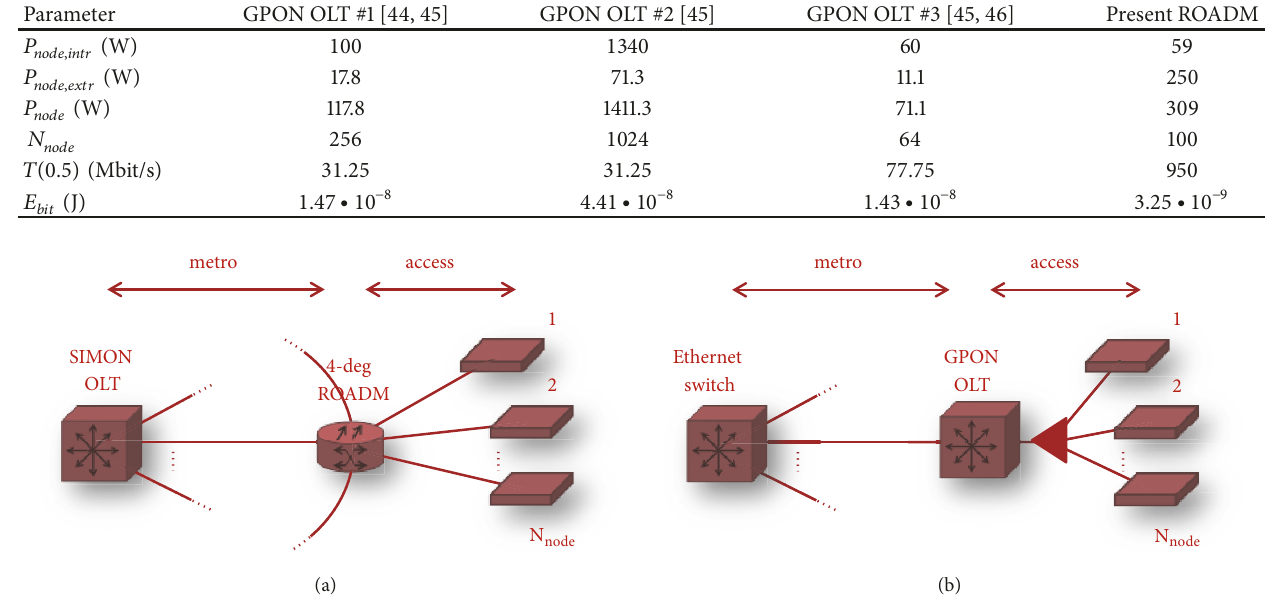
Table 1: Compared power consumption analysis.